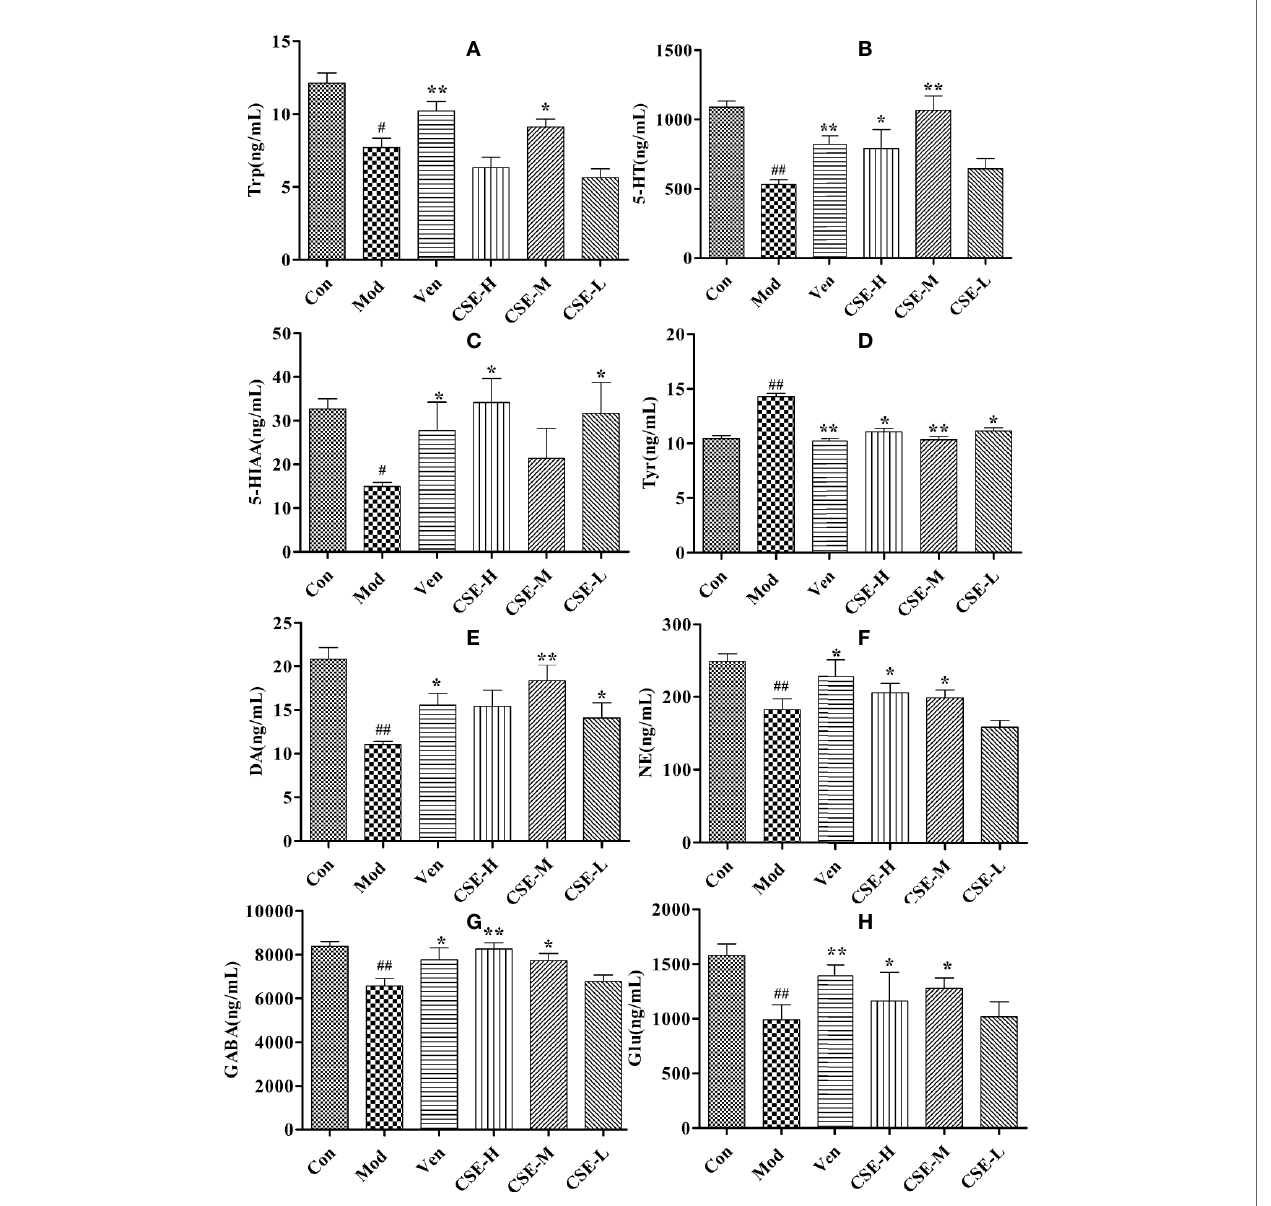
FIGURE 6 | The concentrations of CSE on monoamine neurotransmitter in hippocampus of rats, (A) Trp, (B) 5-HT, (C) 5-HIAA, (D) Tyr, (E) DA, (F) NE, (G) GABA, and (H) Glu. Values given are the mean ± SEM (n = 10). ## P < 0.01, # P < 0.05 compared with the control group. ** P < 0.01, * P < 0.05 compared with the model